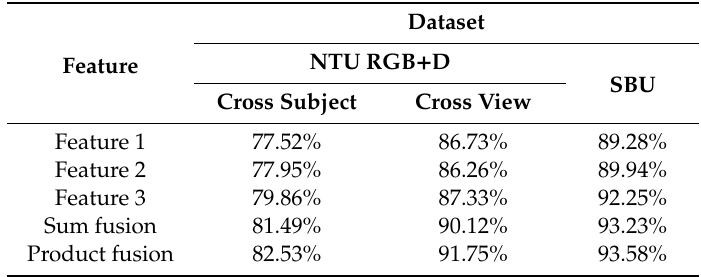
Table 1. Recognition accuracy on NTU RGB + D and SBU datasets.